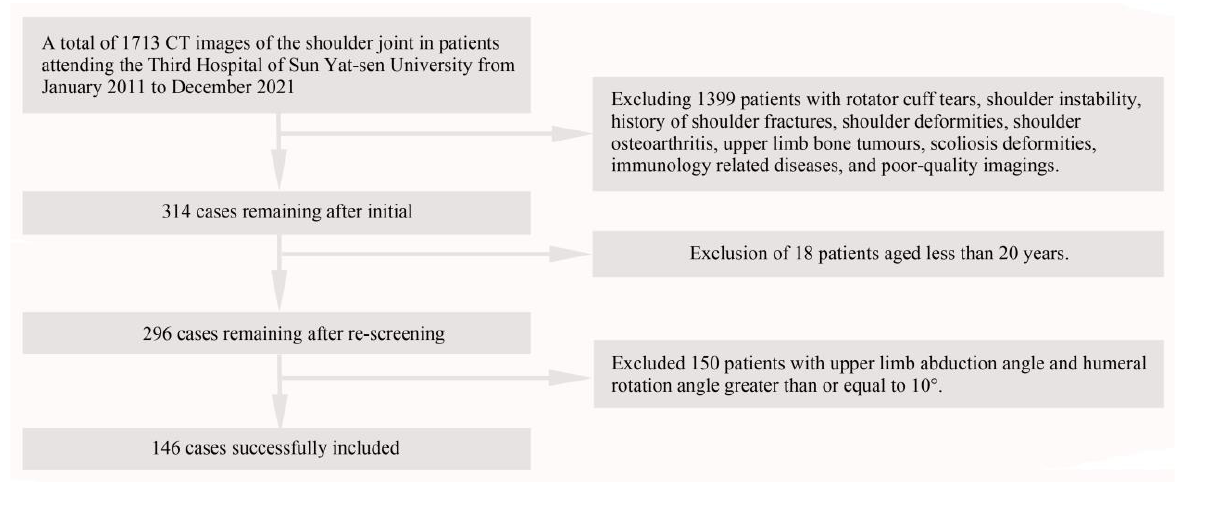
Figure 2. Flowchart diagram of this study. A total of 1713 patients underwent standard CT exami- nations of the shoulder joint and a total of 146 patients were eventually included in the study. Table 1. Numbers of observed joints grouped by age and sex.